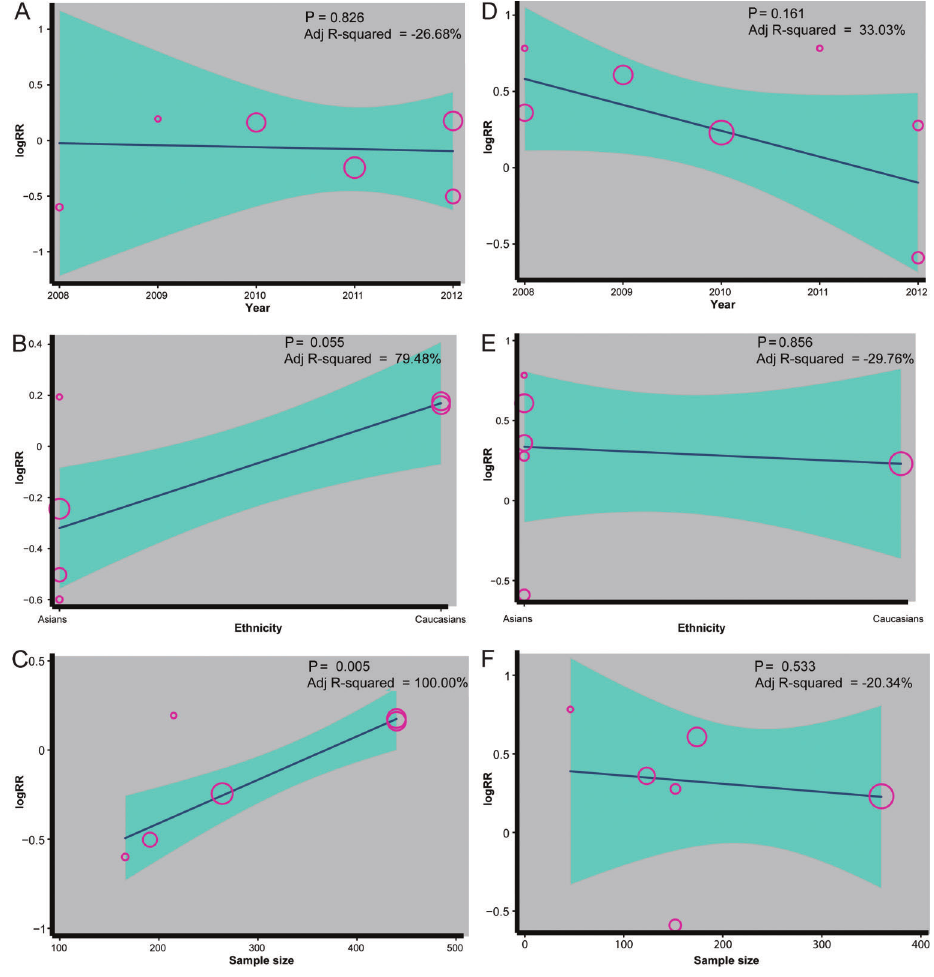
Figure 6. Meta-regression analyses of the Lauren classi fi cation (left panels) and the 5-year survival rate (right panels) of patients with gastric cancer (GC) based on the nine included studies.